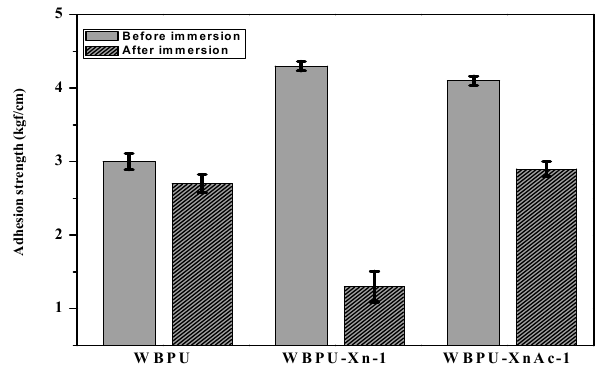
Figure 6. Adhesive strength of typical coatings at different conditions.